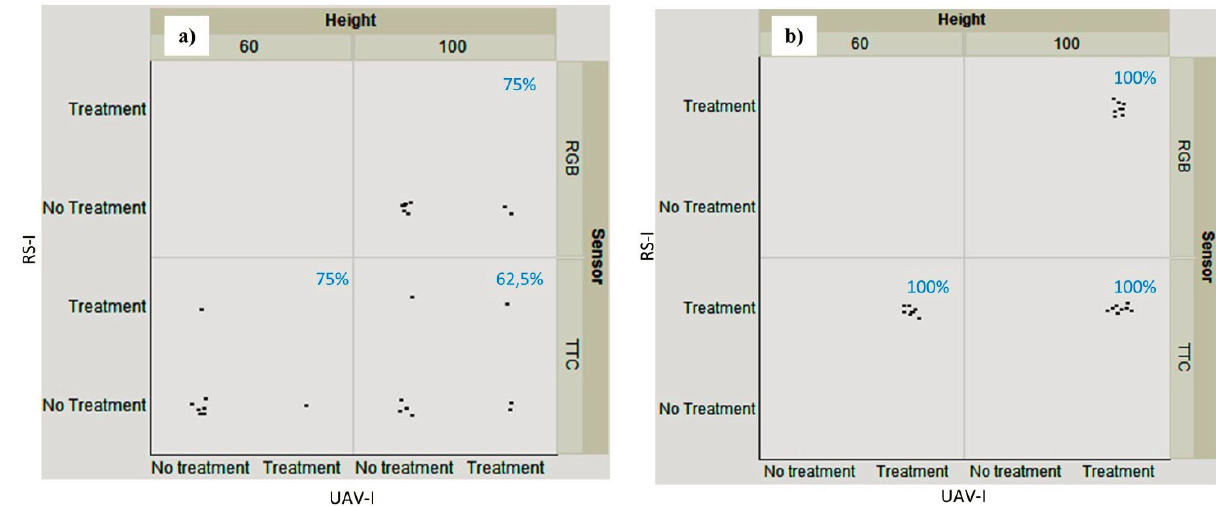
Figure 6. Representation of concordance of Treatment and No-Treatment for every eight frames corresponding to the weed infestation level category 0 and 3 infestation level ( a and b , respectively) for RS-image and UAV-image at 60 and 100 m altitudes, both types of sensors in Field1. Abscissa and ordinate axis correspond to UAV-image and RS-image classification respectively. Percentage of concordance in every case is shown in